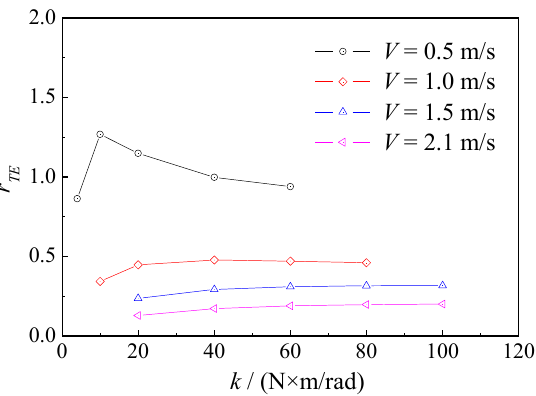
Figure 15. Thrust enhancement ratio ( 𝑟 𝑇𝐸 ) of bow foil at different speeds and different spring stiffness.